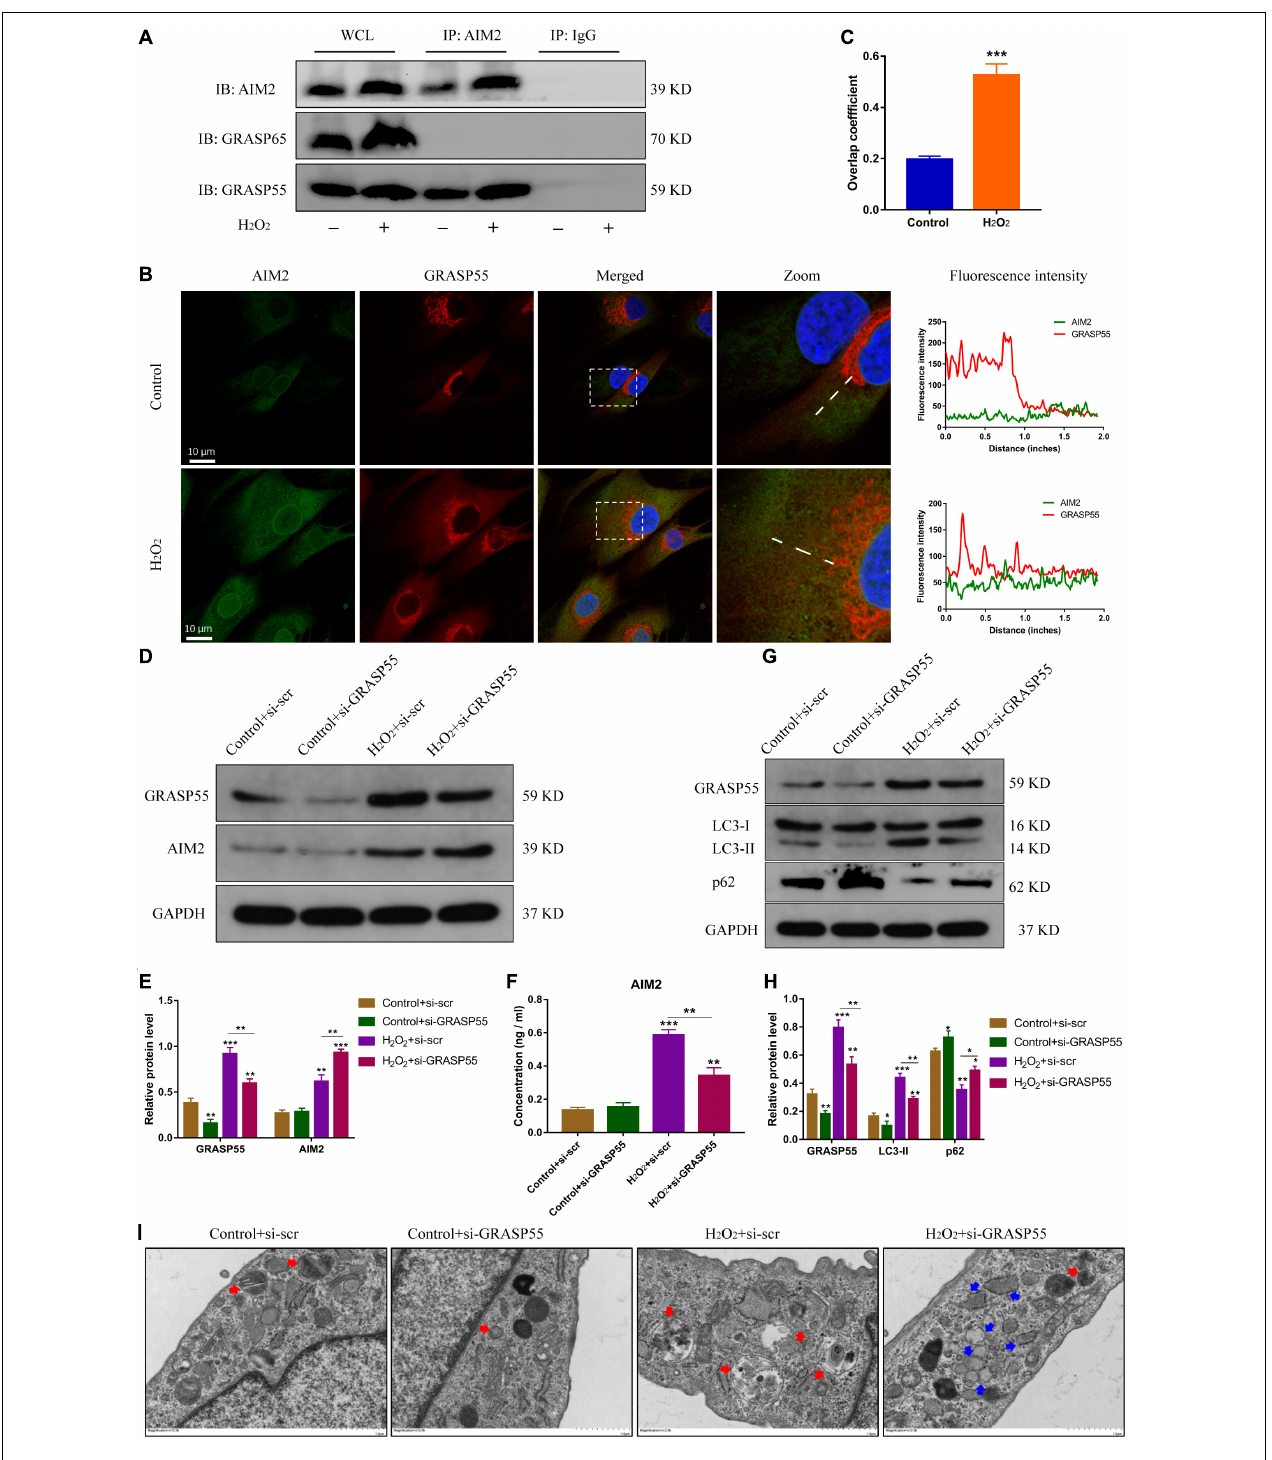
FIGURE 6 | GRASP55 regulates AIM2 unconventional secretion and autophagy activity. (A) Immunoprecipitation for AIM2 was conducted to detect the integration of GRASP55 or GRASP65. (B,C) Confocal images of AIM2 (green) and GRASP55 (red) (B) and overlap coefficient (C) in H 2 O 2 -treated NP cells. (D) Knockdown of GRASP55 in NP cells and corresponding western blot images of GRASP55 and AIM2. (E) Quantification of AIM2 and GRASP55 in H 2 O 2 -treated NP cells with si-GRASP55 or si-scr. (F) Extracellular levels of AIM2 measured by ELISA analysis. (G,H) Protein levels (G) and quantification (H) of GRASP55, LC3 and p62 in H 2 O 2 -treated NP cells with si-GRASP55 or si-scr. Data were presented as the means ± SD, n = 3. * P < 0.05, ** P < 0.01, *** P < 0.001 vs. control group. (I) TEM images of NP cells showed the autophagosomes (red arrows) and other irregular intracellular vesicles (blue arrows).